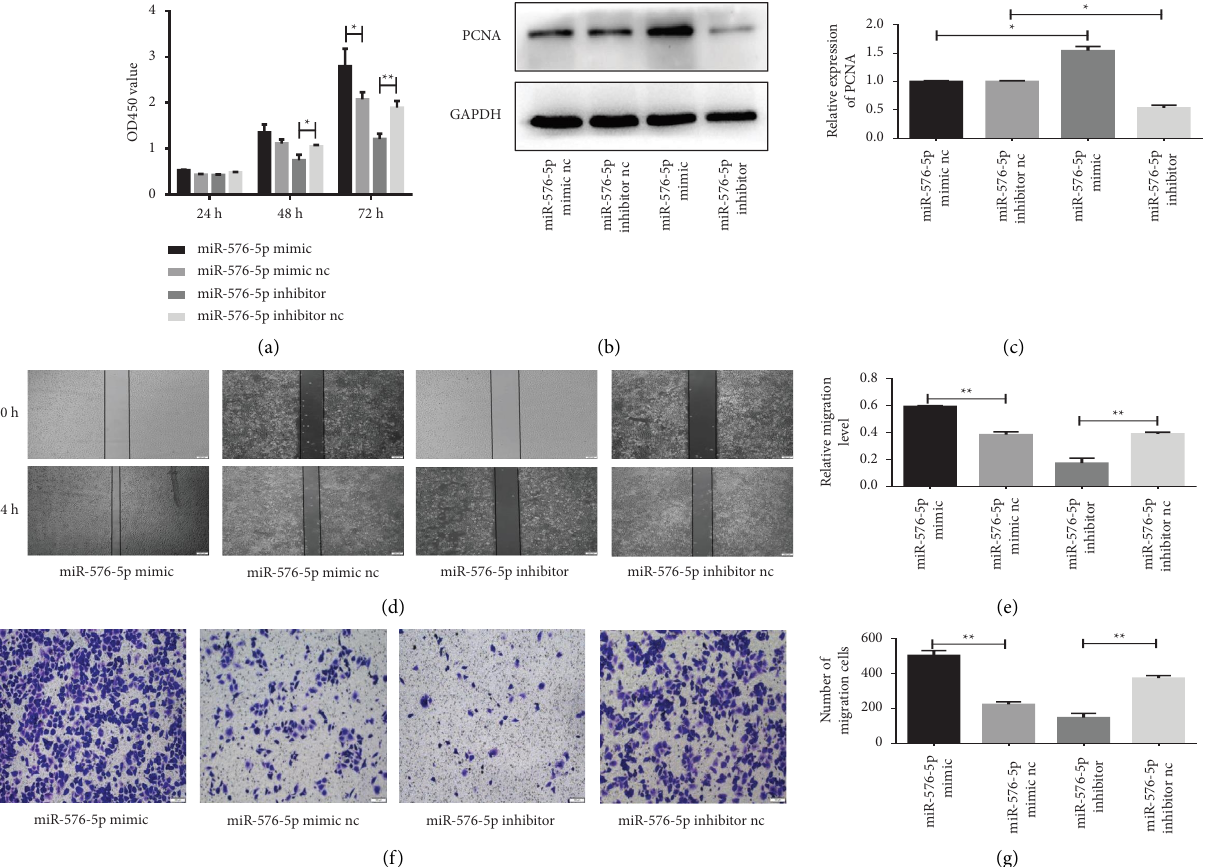
Figure 2: Overexpression of miR-576-5p promotes the proliferation, migration, and invasion of TPC-1 cells. (a) A CCK-8 assay was performed to evaluate cell proliferation. (b, c) Te proliferation-related protein PCNA was evaluated by western blotting. (d, e) Te efect of miR-576-5p on the migration of TPC-1 cells was examined by wound healing assays. (f, g) Te efect of miR-576-5p on the invasion of TPC- 1 cells was examined by transwell assays. ∗ P < 0 . 05 ; ∗∗ P < 0 .